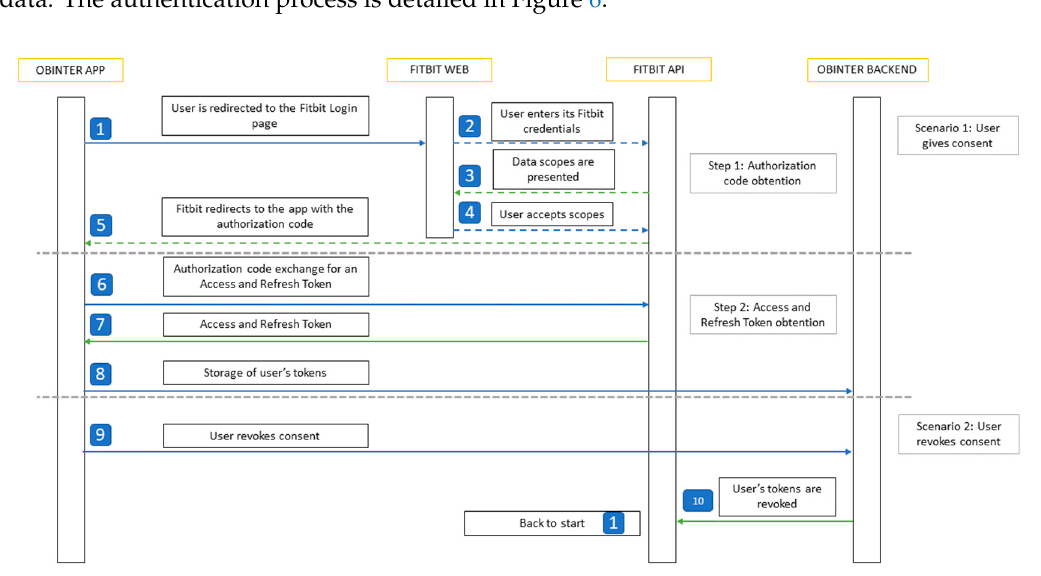
Figure 6. Sequence diagram describing the workflow to integrate Fitbit’s user authorization rotocol.